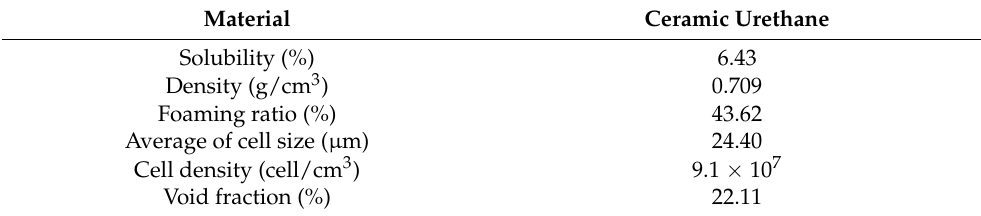
Table 3. Results of the fabrication of microcellular foamed ceramic urethane.